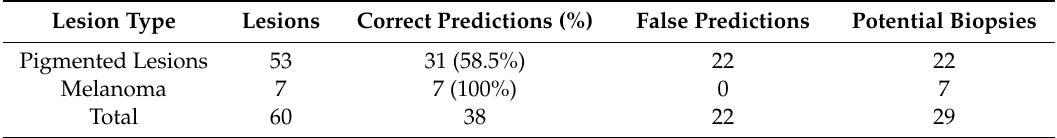
Table 1. Prediction accuracy